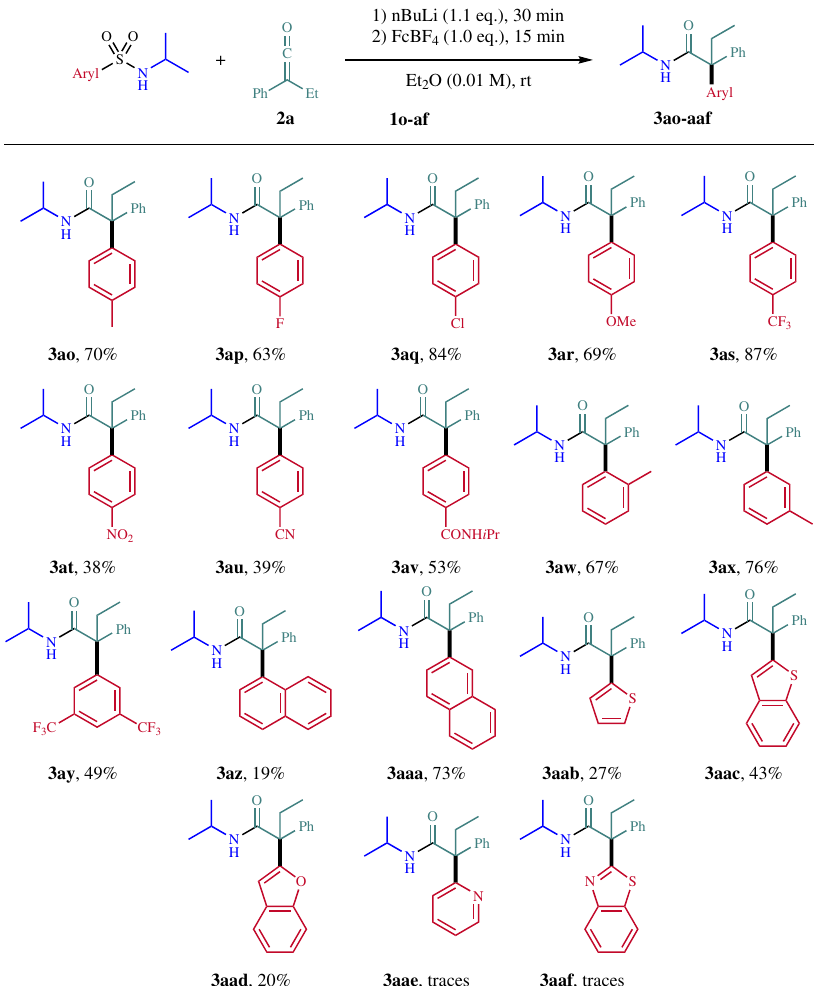
Fig. 3 Variation of migrating aryl group. Reaction scale: 0.200 mmol. Ketene 2a in Et 2 O (0.06 M ) over 30 min by syringe pump. FcBF 4 = Ferrocenium tetra fl